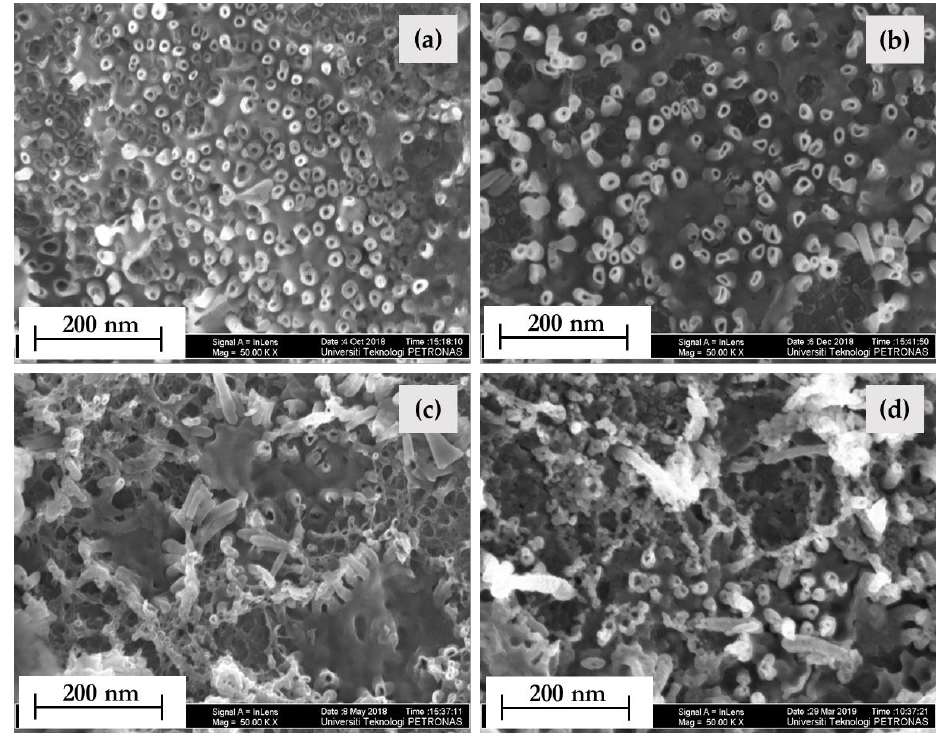
Figure 4. Field emission scanning electron microscopy ( FESEM) images of anodized Ti foil for ( a ) uncalcined and after calcination at ( b ) 350 °C, ( c ) 450 °C, and ( d ) 550 °C at 50 kX magnification.